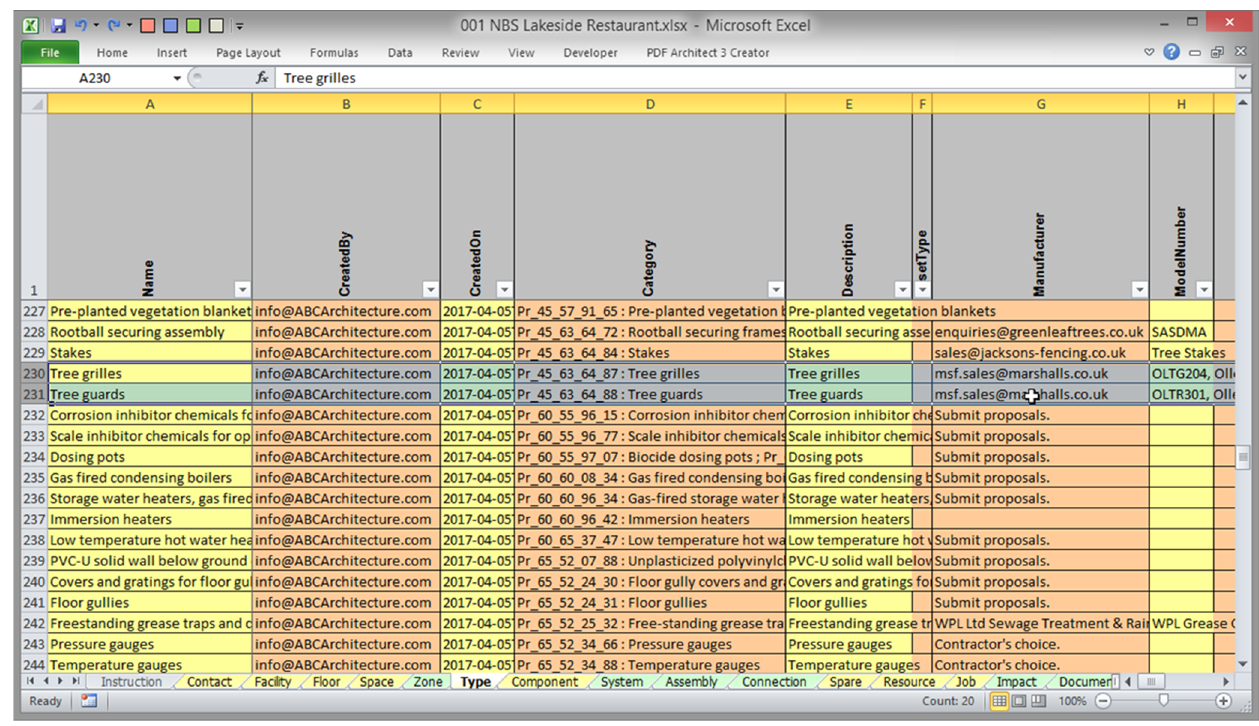
Figure 2. Example of COBie sheet. Source: [48].